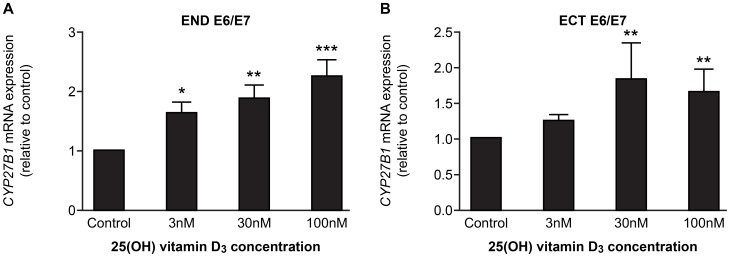
Effect of 25(OH) vitamin D3 on CYP27B1 expression in endocervical (END E6/E7) and ectocervical (ECT E6/E7) cell lines.Cells treated for 24(control), 3 nM, 30 nM or 100 nM 25(OH) vitamin D3. (A) End E6/E7 cells (n = 3), (B) Ect E6/E7 cells (n = 3). Data presented as mean fold change relative to control ± SEM (error bars). *, **, **, p<0.05, 0.01, 0.001 respectively compared with control (One-way ANOVA with Dunnett's post-test).